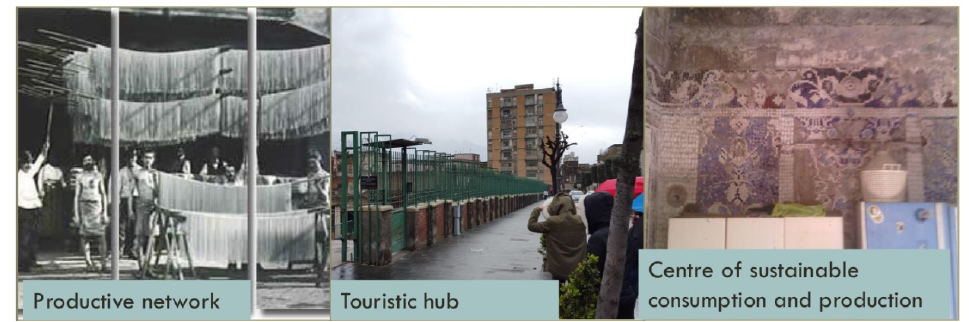
Figure 8: The contribution of art in the proposed scenarios of